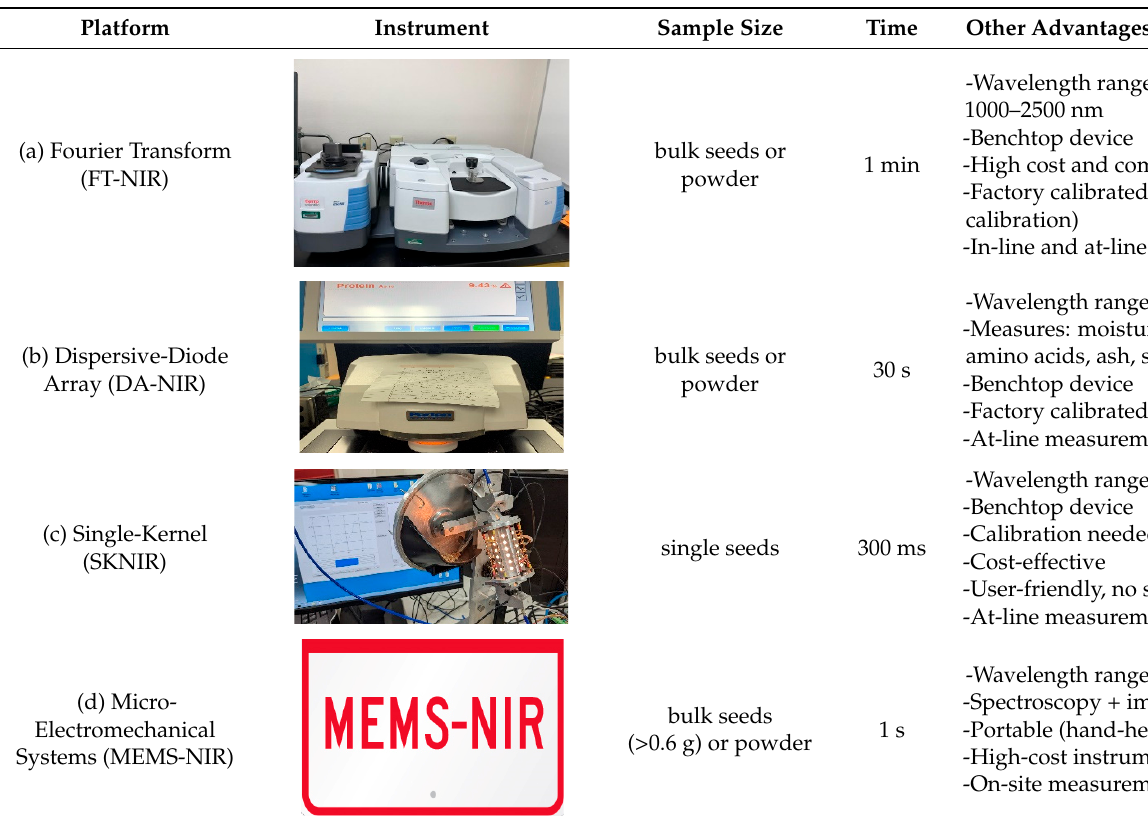
Table 1. Summary of six major non-destructive seed phenomics techniques at a glance. Fourier Trans- form (FT-NIR), Dispersive-Diode Array (DA-NIR), Single-Kernel (SKNIR), Micro-Electromechanical Systems (MEMS-NIR), Hyperspectral Imaging (HSI), and Micro-Computed Tomography Imag- ing